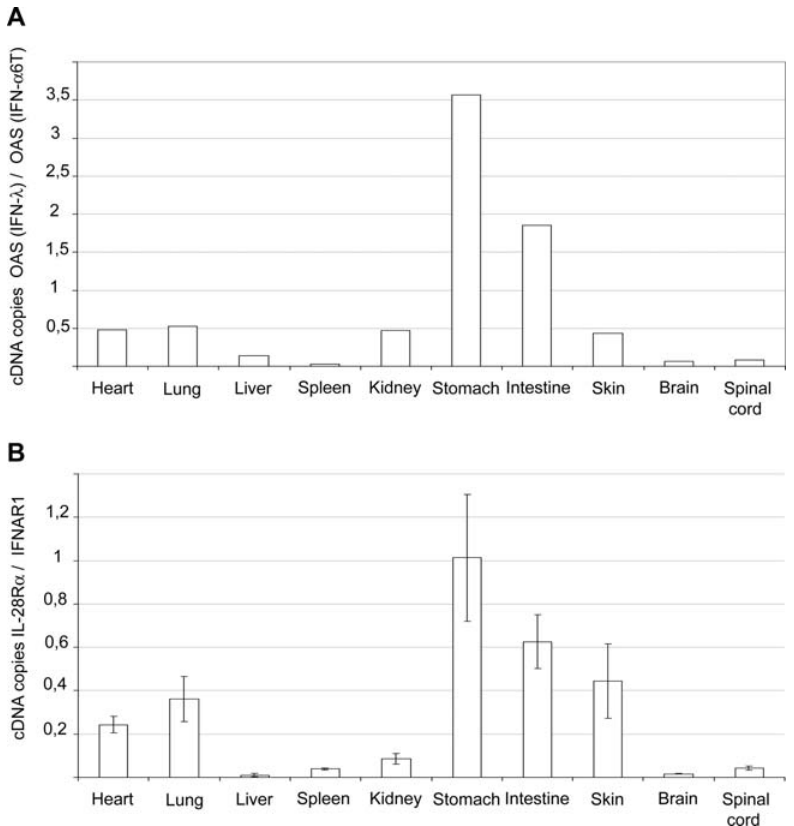
Figure 9. Correlation between the relative responsiveness of organs to IFN- l and the relative expression of IL-28R a and IFNAR1. A. Relative functional influence of IFN- l over IFN- a in various organs. The histogram shows, for each organ, the ratio between OASl2 expression in response to circulating IFN- l and OASl2 expression in response to circulating IFN- a (mean of two mice), 7 days after electrotransfer of the expression plasmids. B. Relative expression, measured by real-time RT-PCR, of IL-28R a and IFNAR1 (mean and SD from 5